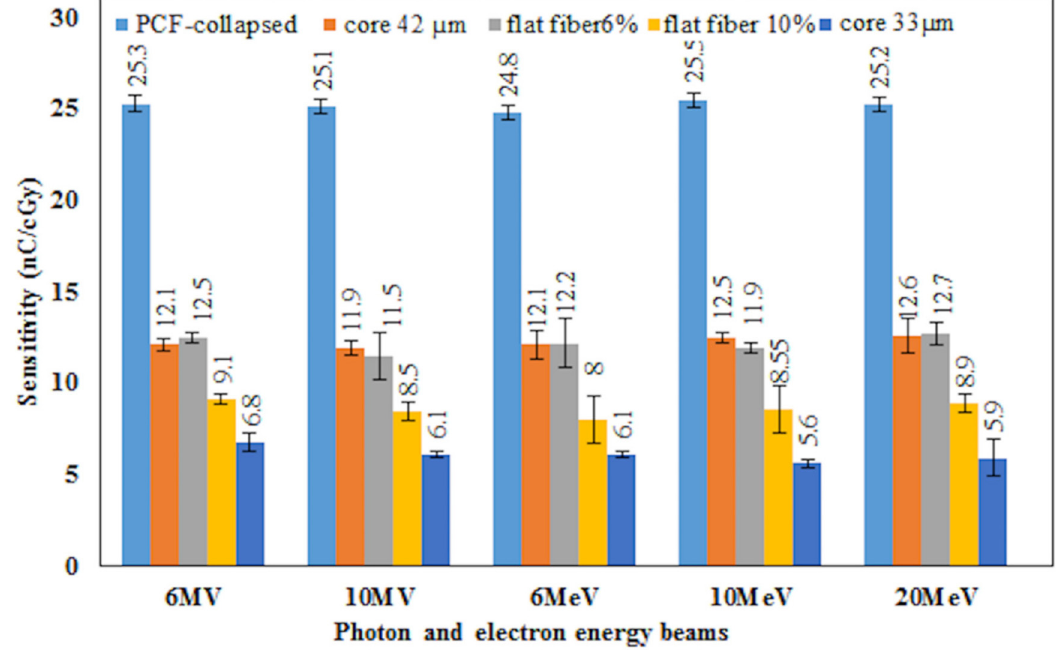
Fig 2. Sensitivity of fibres of PCF-collapsed, comparison of sensitivity of 42 μ m &33 μ m core sizes cylindrical and flat fibres (10% & 6% Ge-dopant) for different energies is